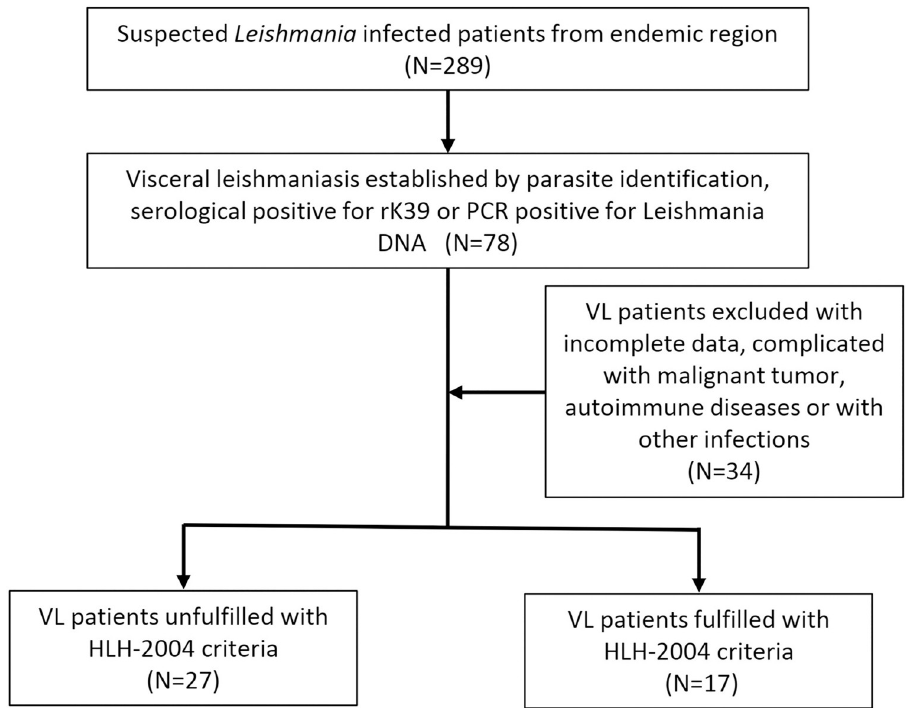
Fig 1. Flow chart for VL and VL associated HLH